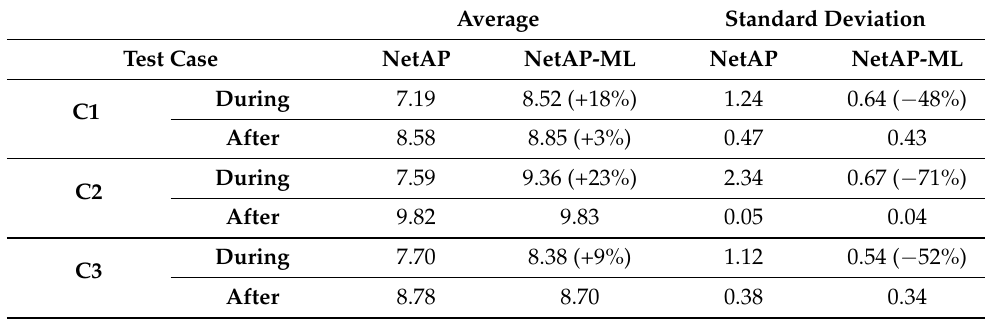
Table 1. Average and standard deviation (in Gb/s) for the second